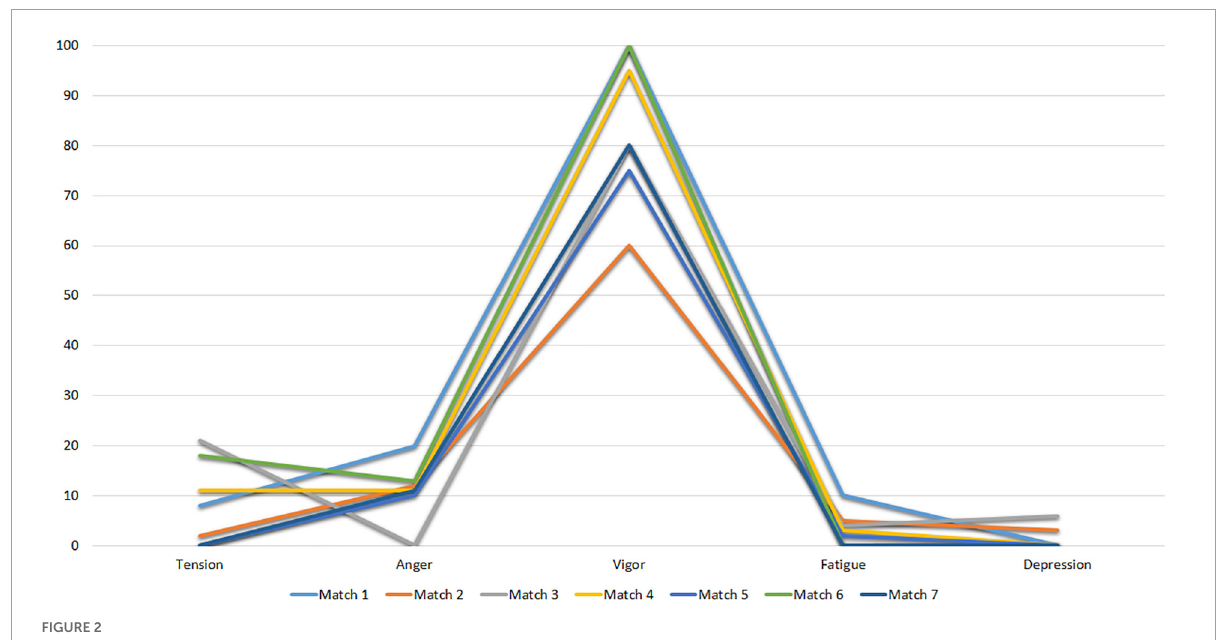
FIGURE2 POMS profiles of subject I after matchs.